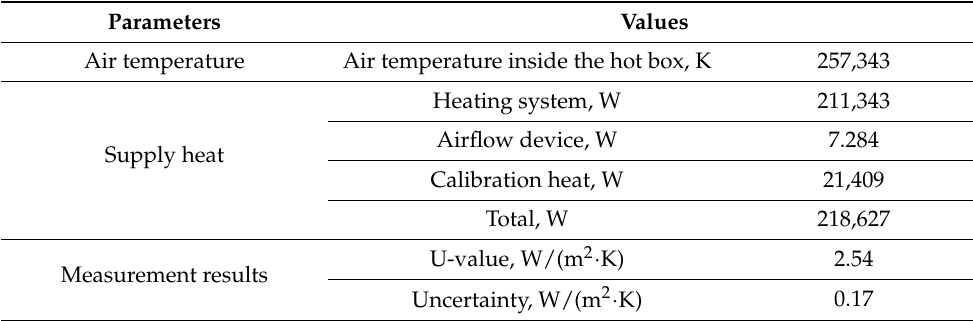
Table 3. Window KS F 2278 thermal performance average